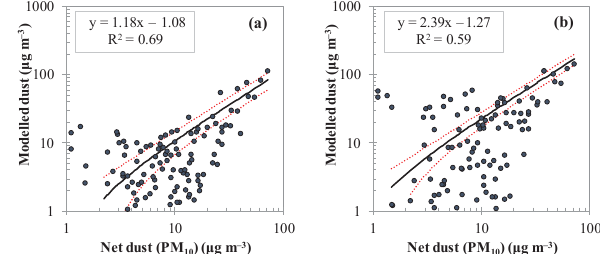
Figure 12. Deming regression analysis between net dust calculated through PM 10 regional background data and dust concentrations modelled at surface level by (a) the SKIRON/Dust and (b) the BSC DREAM8b v2.0 model, for the city of Athens. The black line cor- responds to the linear regression equation, while the red dotted lines are the upper and lower bounds, at the 95% confidence